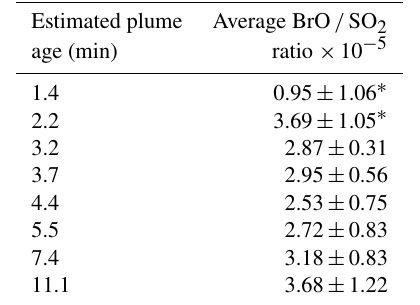
Table 7. BrO / SO 2 ratios from a stationary NOVAC DOAS instru- ment at the estimated plume ages obtained from wind speed (see Sect. 3.5 and Fig. S2). Values marked with “*” are single data points with the uncertainty of the single measurement. The other uncer- tainties are derived from multiple measurements and the respective standard deviation.